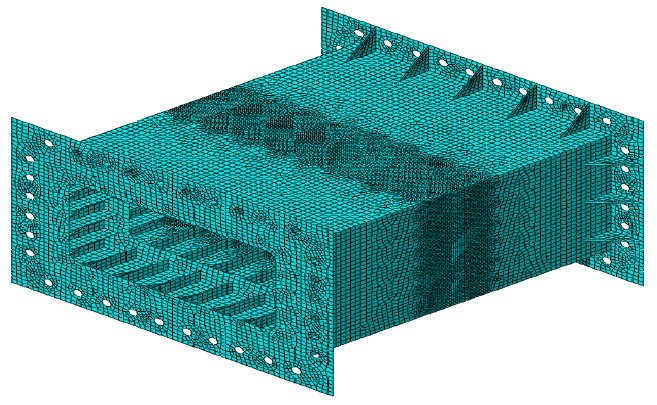
Figure 18. Numerical modeling of the experimental model.